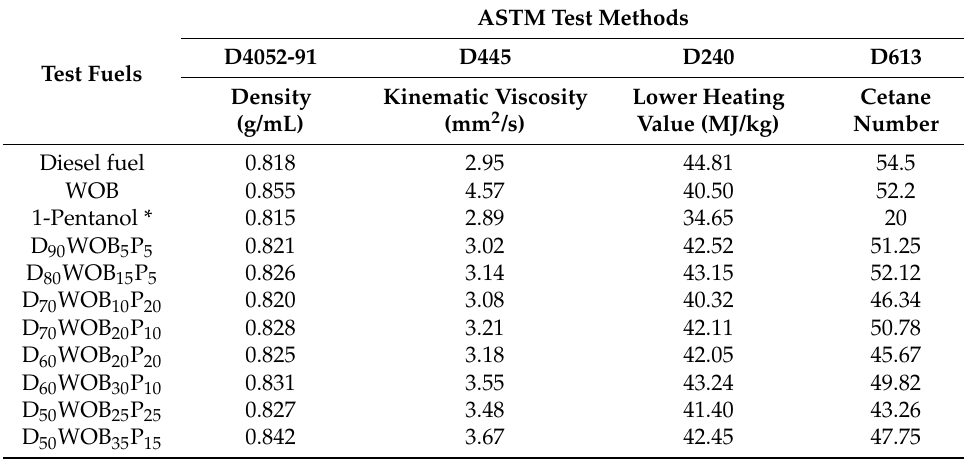
Table 2. The basic properties of test fuels.